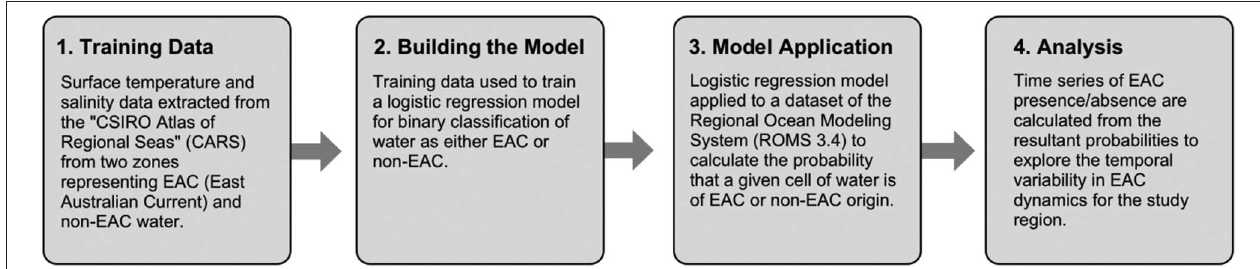
FIGURE 2 | Schematic of the classification algorithm construction process.